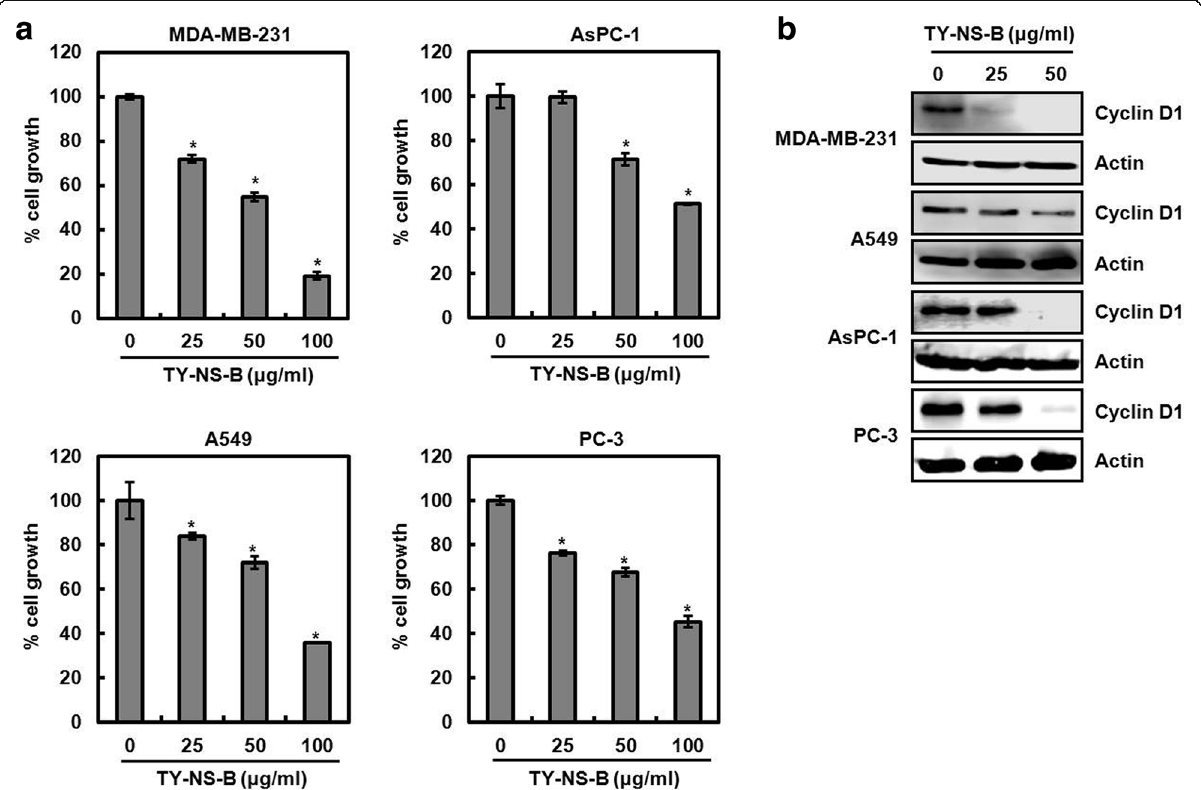
Fig. 3 The effect of TY-NS-B on the cell growth and cyclin D1 expression in other cancer cells. a Human breast cancer cells (MDA-MB-231), human pancreatic cancer cells (AsPC-1), human non-small cell lung cancer cells (A549) and human prostate cancer cells (PC-3) were plated overnight and then treated with TY-NS-B at the indicated concentrations for 24 h. Cell growth was measured using MTT assay. Data represent mean ± SD for three independent experiments. * P < 0.05 compared to cell without TY-NS-B. b MDA-MB-231, AsPC-1, A549 and PC-3 were plated overnight and then treated with TY-NS-B at the indicated concentrations for 24 h. Cell lysates were subjected to SDS-PAGE and the Western blot was performed using antibody against cyclin D1. Actin was used as internal control for Western blot